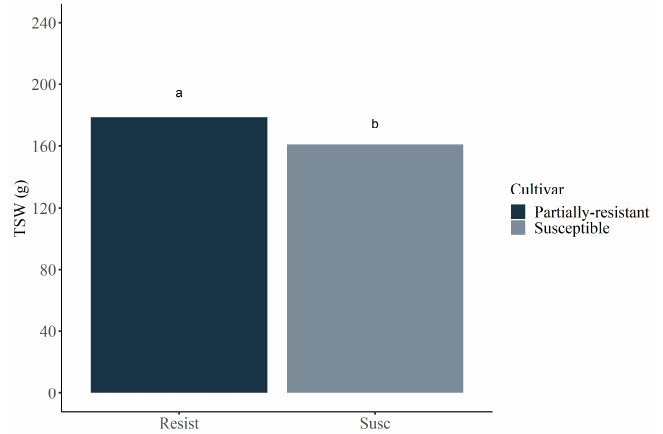
Figure 16. Mean values of thousand seeds weight (TSW) (g) as a function of soybean rust effect over different soybean cultivars in the experimental Field 2. The means followed by the same letter did not differ by Tukey’s test at 5% probability ( p <